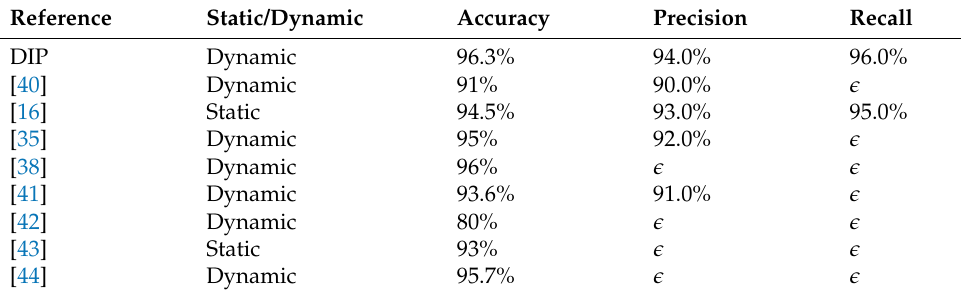
Table 6. Benchmarking DIP against related